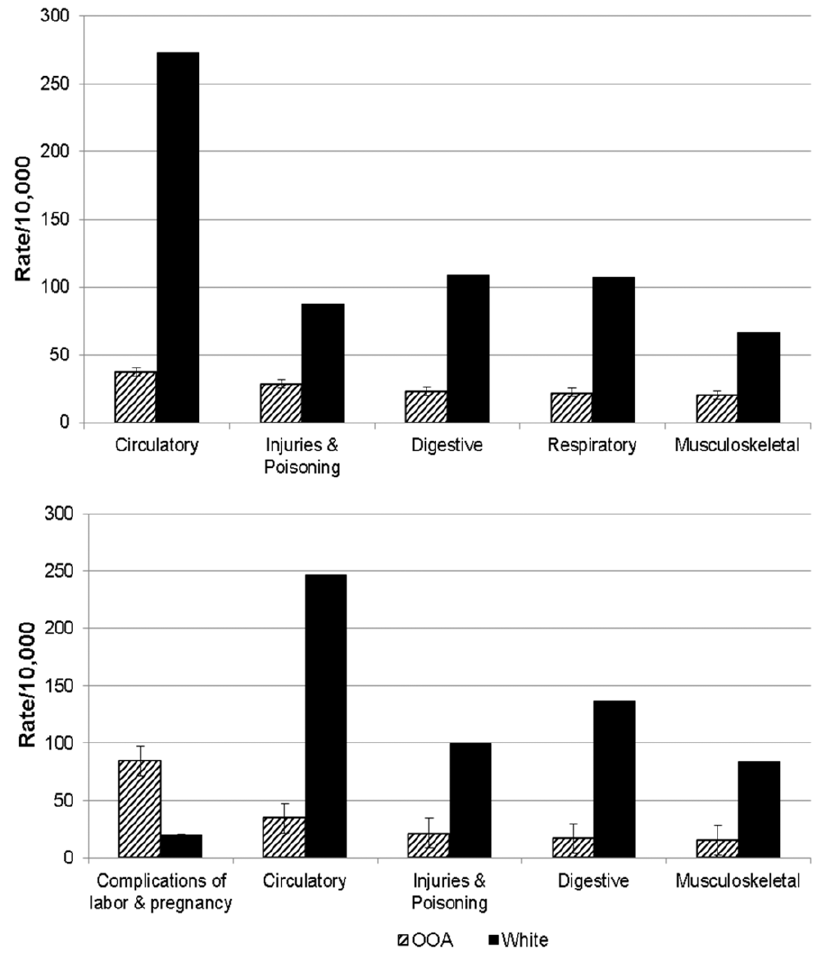
Figure 2. Annualized rates of first-listed hospital discharges in Lancaster County Old Order Amish (OOA) (solid bar) and US Caucasians (striped bar) for ages 25 years and older. The five leading diagnostic categories in the OOA are shown. Non-Amish white hospital discharge rates from NHDS. OOA and US Caucasian hospital discharge rates obtained for the period 2002–2004 and annualized. Men are in the upper panel and women are in the lower panel.